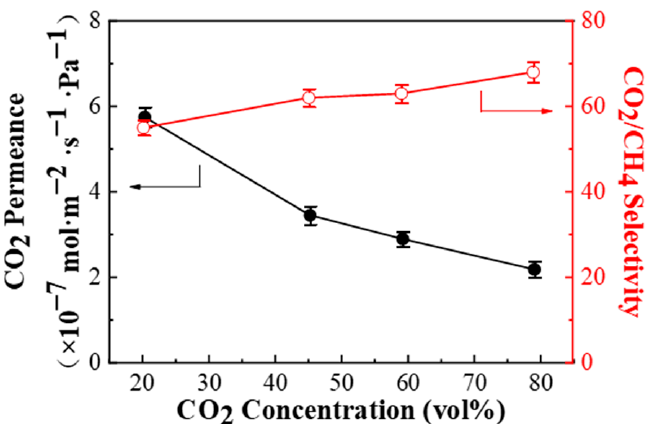
Figure 9. Effect of the feed gas CO 2 concentration on the CO 2 /CH 4 mixed gas separation performance of PPPS/PDMS/PSf composite membrane. Test conditions: 298 K, saturated humidity, and 0.15 MPa. According to the formula obtained by Zhang et al. [29], the CO 2 permeance of the facilitated transport membranes can be defined by Formula